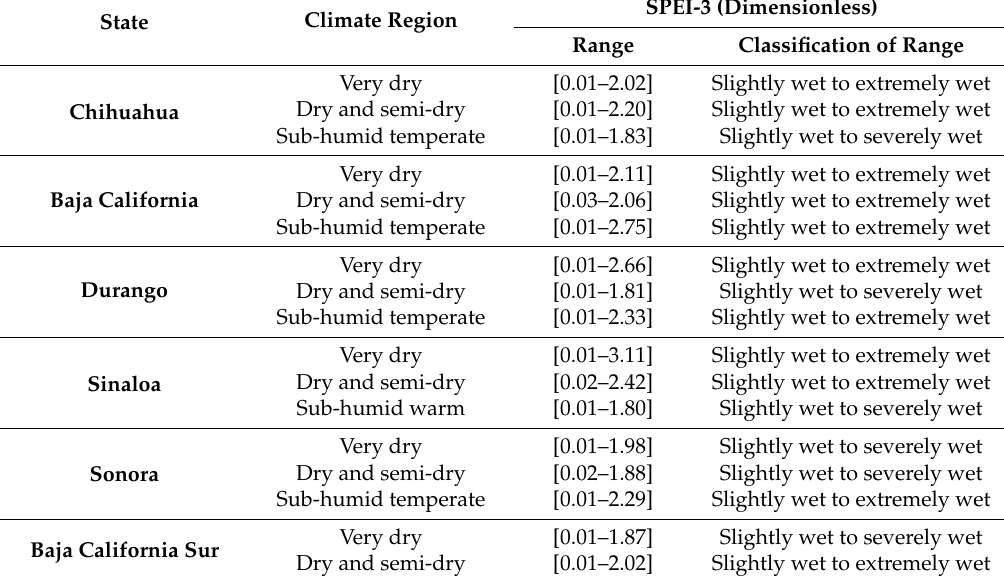
Table 4. Variation, extreme events and classification of SPEI-3 by climate region in